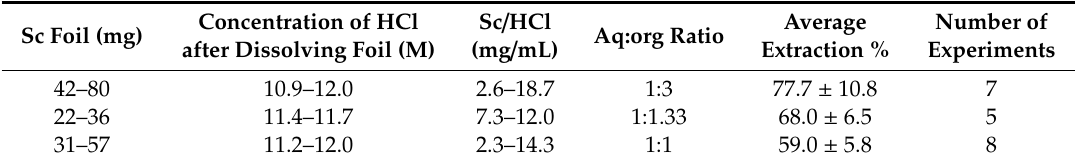
Table 1. The average extraction e ffi ciency of 45 Ti at di ff erent ratios between the aqueous and organic phases. The mass of scandium foil, the HCl concentration after dissolving the scandium foil, the mass of scandium per volume, and the number of experiments are